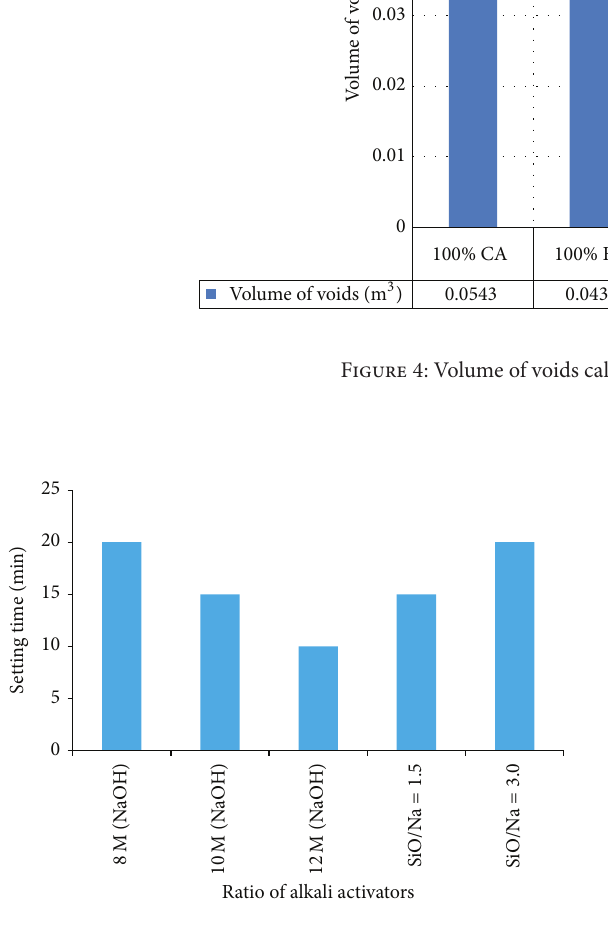
Figure 5: Setting time test for various dosages of alkali